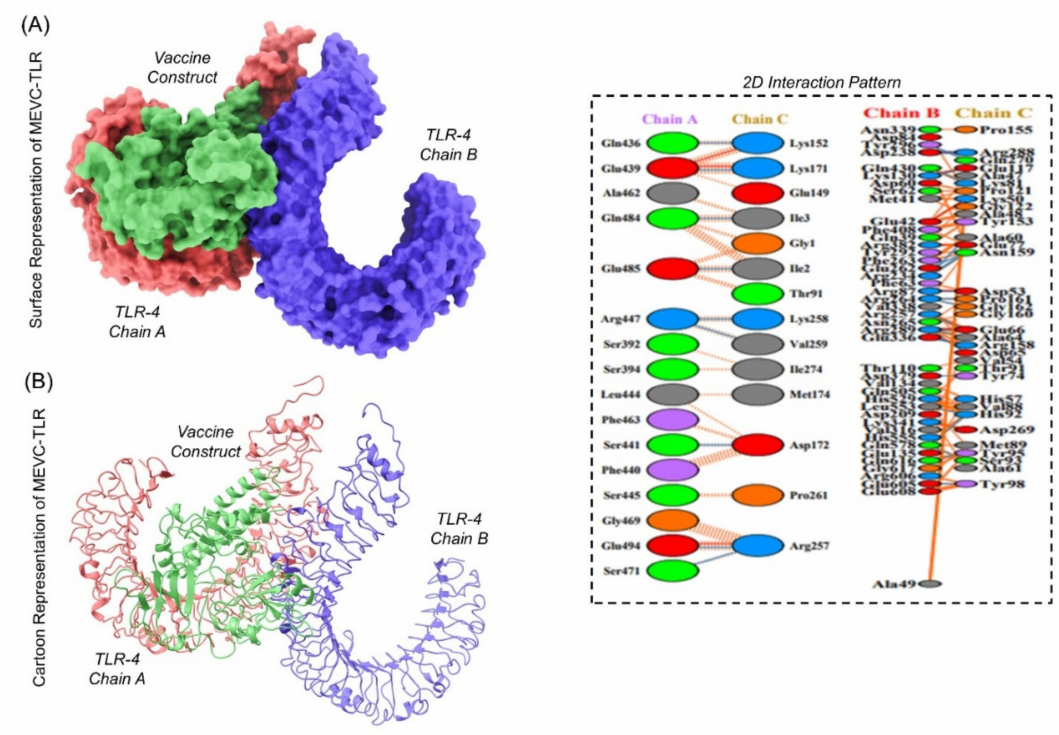
Figure 7. The docked complex of the constructed immunogen and the TLR4 homodimer receptor with A and B Chains. Whereas (blue color) represents the B-chain of TLR4, (orange color) represents the A- chain of TLR4, while (green color) represents the designed immunogen in all the of the representative images. ( A ) Surface representation of the docked complex. ( B ) Cartoon shape and the front side of the docked complex. The right panel represents the 2D interaction pattern of the docked